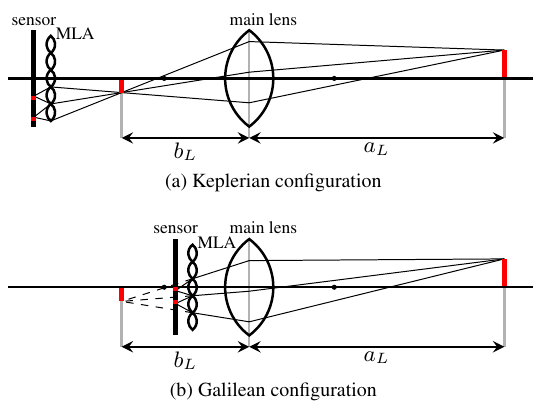
Figure 2. Optical path inside a focused plenoptic camera based on the Galilean configuration.